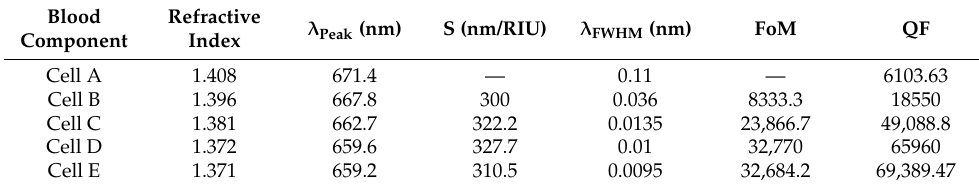
Figure 8. Transmission spectra showing five defect modes in solid blue, black, brown, yellow and purple line colors corresponding to RBC sample containing A, B, C, D and E blood cells separately, one at a time. The thickness of cavity layer is dd = 5000 nm under normal incidence. Table 3. Performance evaluation table showing the numeric values of sensitivity, full width half maximum, figure of merit and quality factor of the proposed biosensor, corresponding to different RBC components under optimum